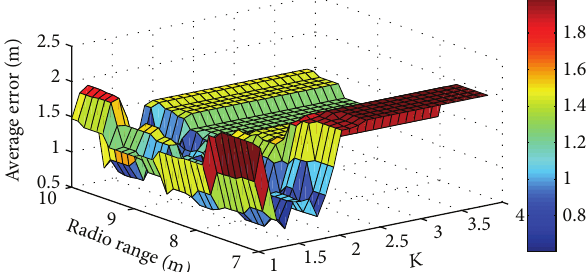
Figure 12: Average estimation error with different sensing radii and power-level ratios 𝑘 for path